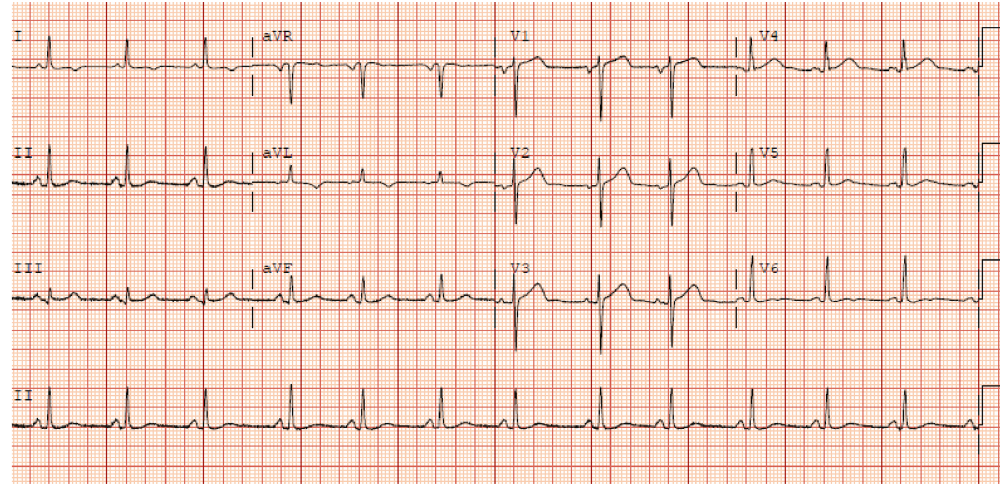
Figure 4: 12-lead electrocardiogram obtained one week prior to the patient undergoing TURBT with intravesical mitomycin C instillation showing normal PR and ST segments in all